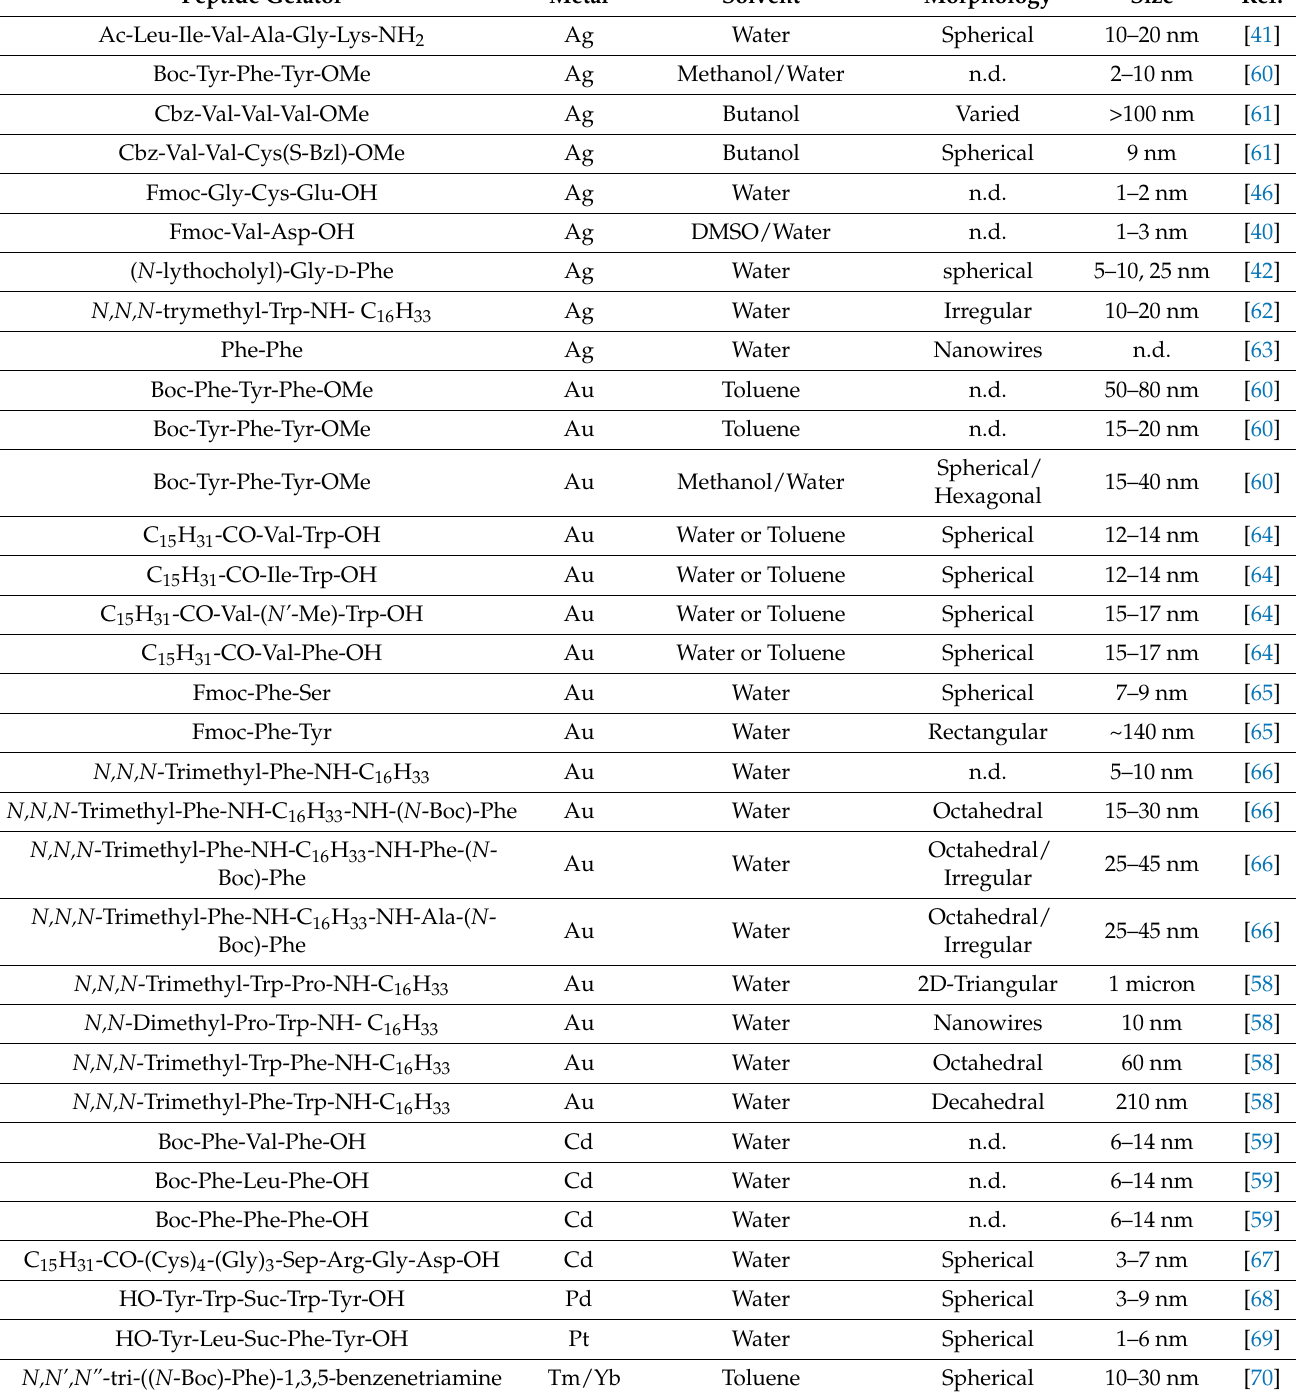
Table 1. Metal NP formation templated by peptide gelators. n.d. = not